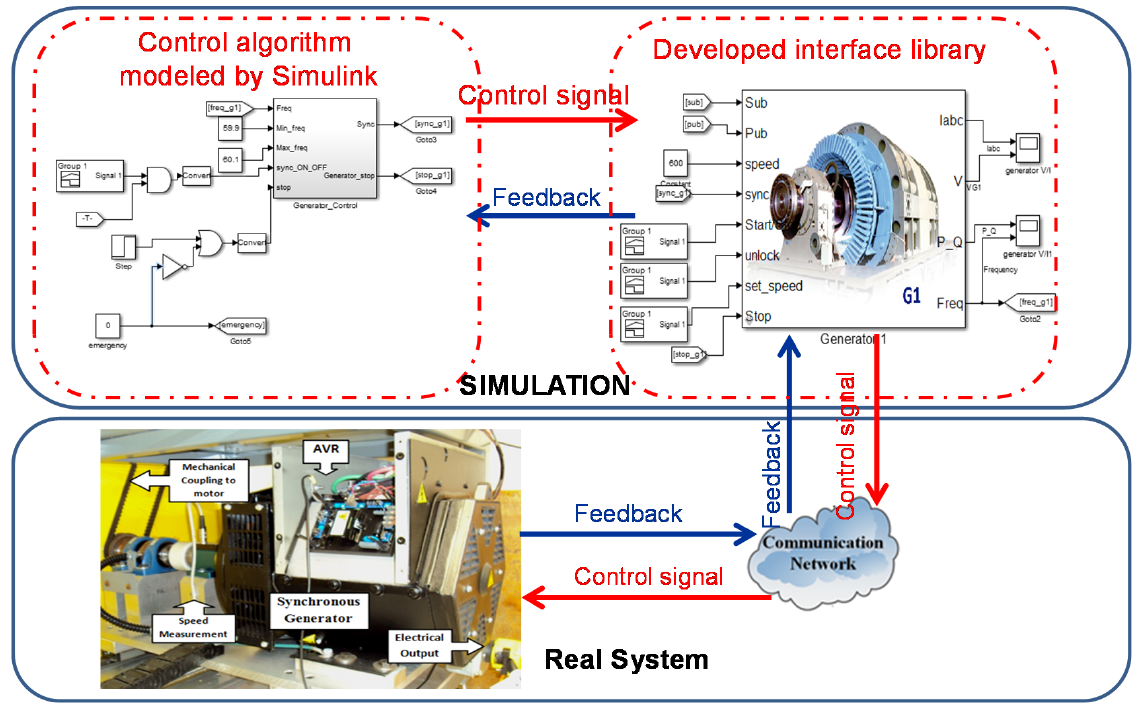
Figure 10. Hardware ‐ in ‐ the ‐ loop (HIL) implementation using DDS and the developed interface